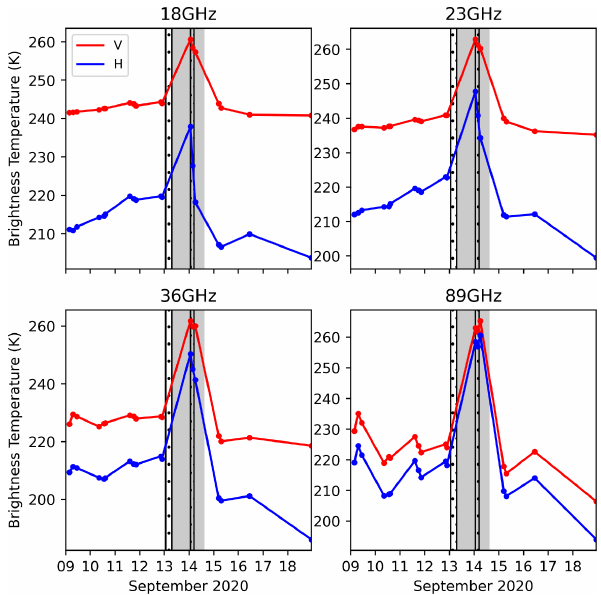
Figure 9. AMSR2 brightness temperatures from 9 until 18 Septem- ber. Data are shown for the MOSAiC floe location as extracted from individual swaths (see Table